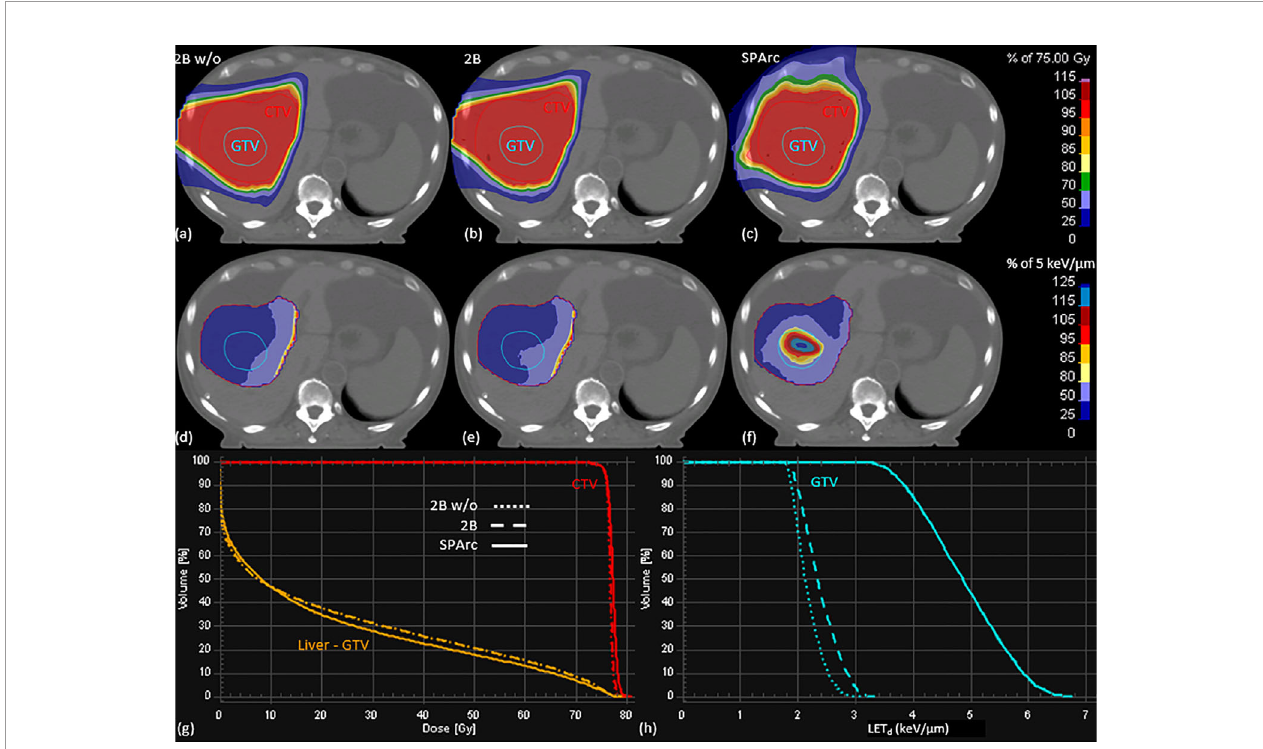
FIGURE 5 | The dose ( fi rst row) and LET d (second row) distributions, the DVHs (G) and LVHs (H) of 2Bw/o (A, D) , 2B (B, E) , and SPArc (C, F) plans for the liver